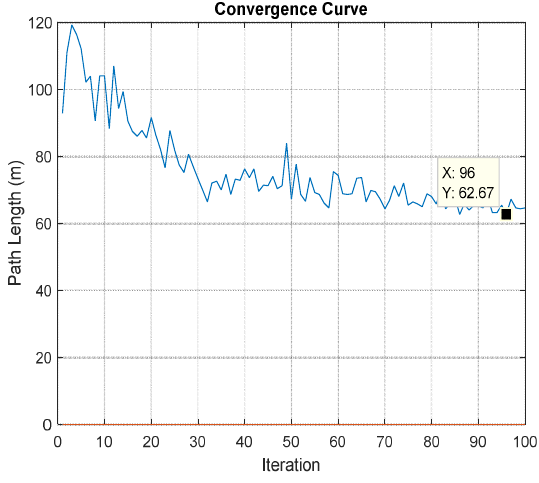
Fig. 17. the Convergence Curve for Experiment 4 From the previous two figure, the mobile robot start avoids static obstacles with the shortest path is (62.6690) in iteration (96) with the total computation time equal to (134.770856).